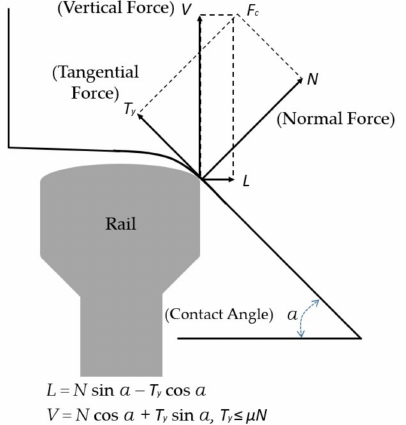
Figure 1. Interaction forces between the wheel and rail.